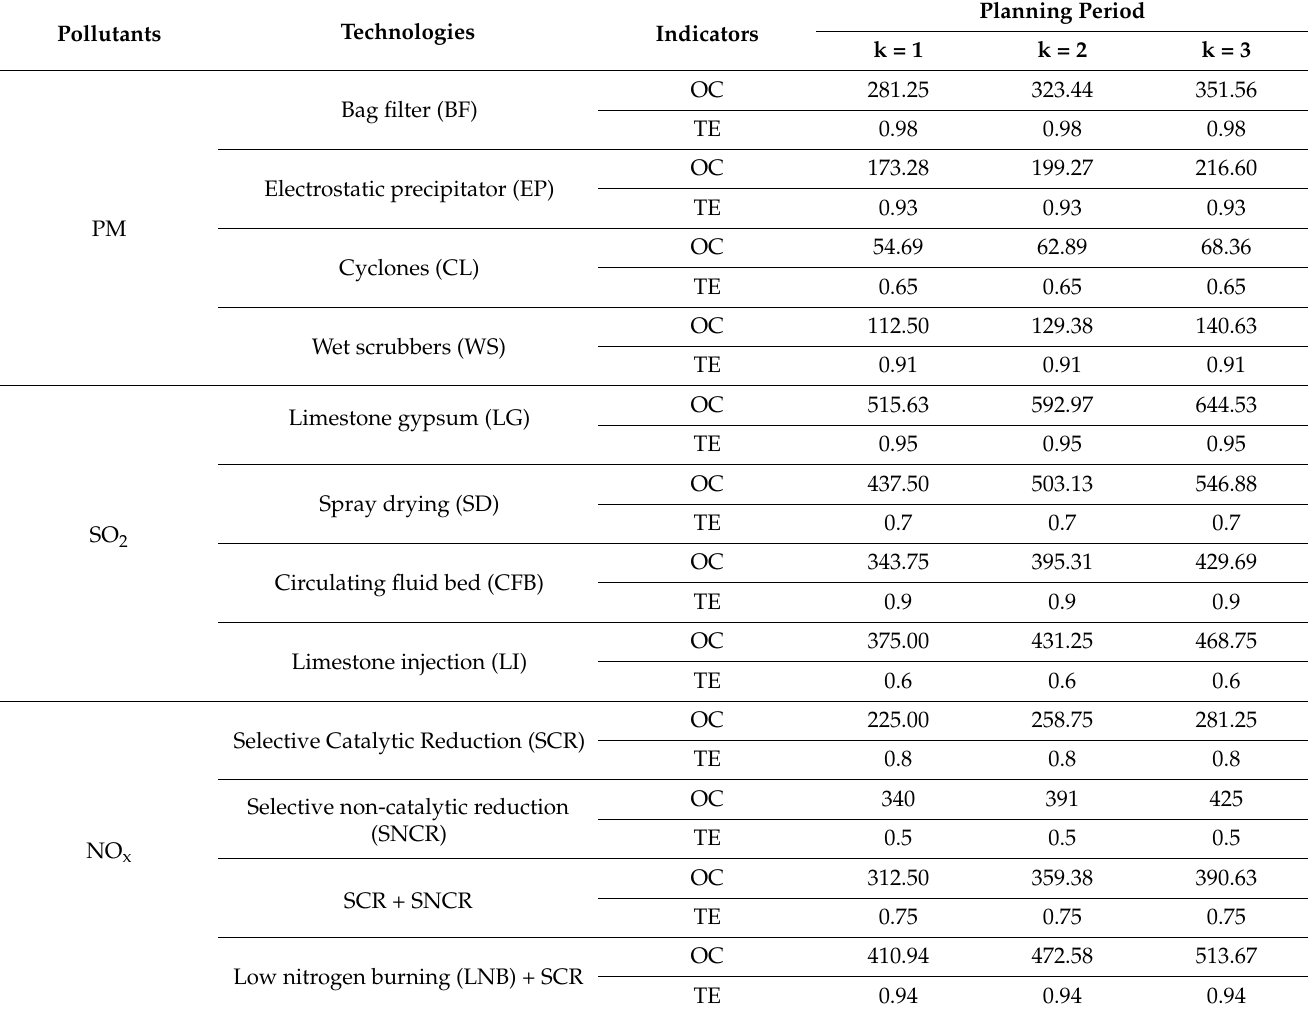
Table 3. The treatment cost and efficiency of twelve candidate